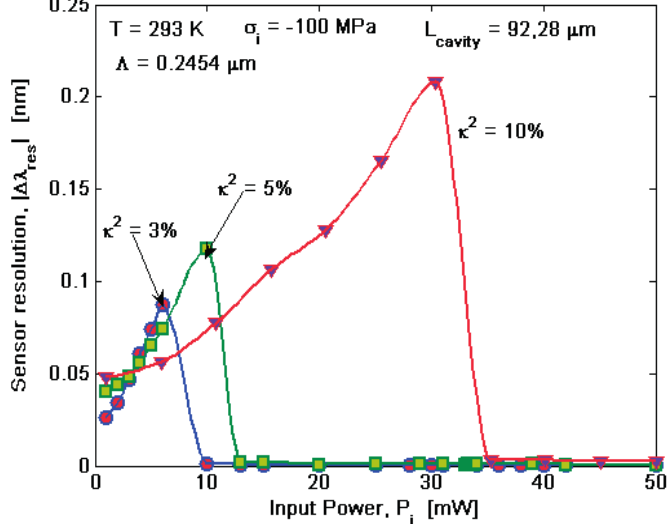
Figure 11. Sensor resolution (detection of level) as a function of input power for different values of the coupling factor between microcavity and external bus